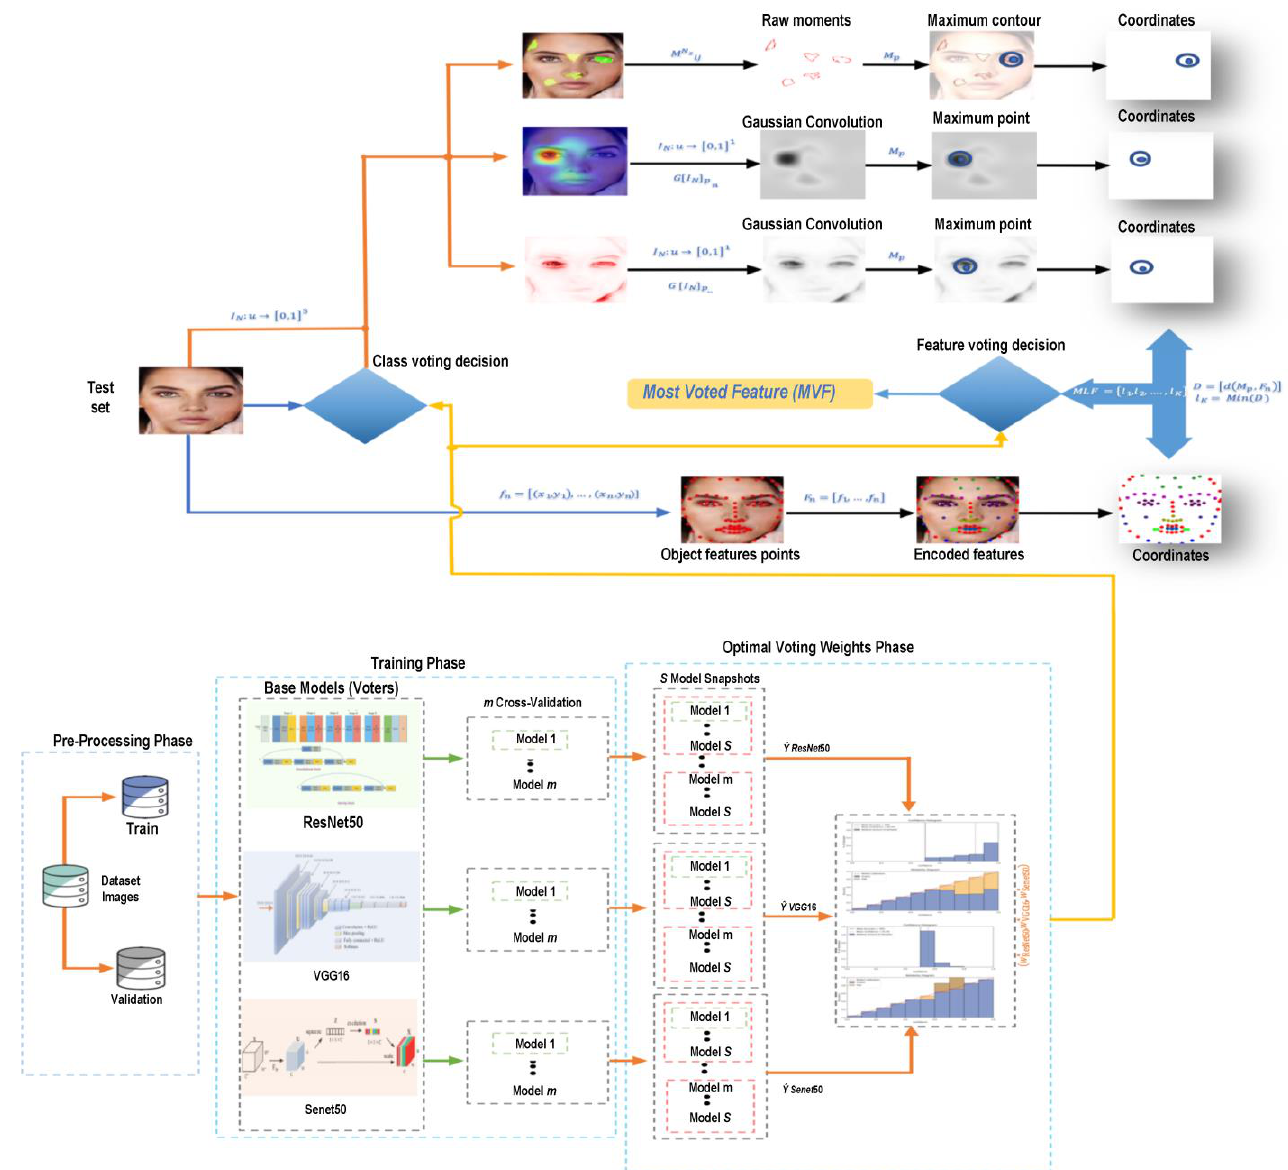
Figure 4. Framework of the proposed method.